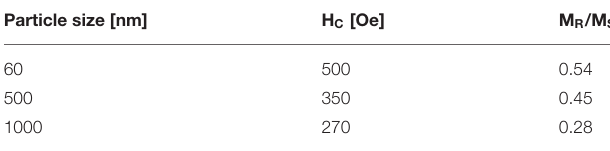
TABLE 1 | Dependence of the coercivity H C on the particle